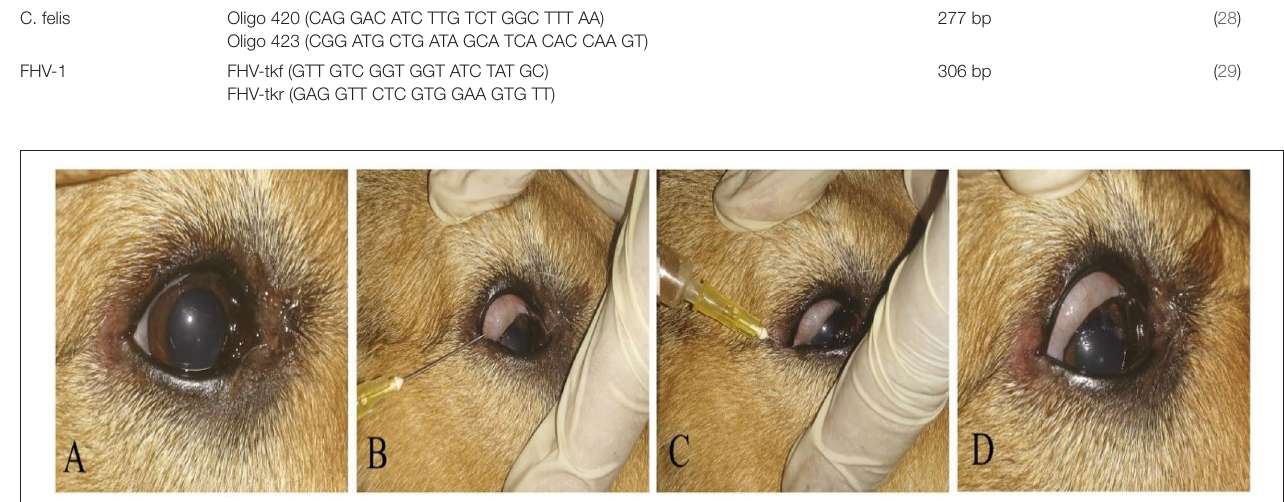
conducted via digital photographs of the ulcer at the baseline and at each time of subconjunctival injection ( Table 2